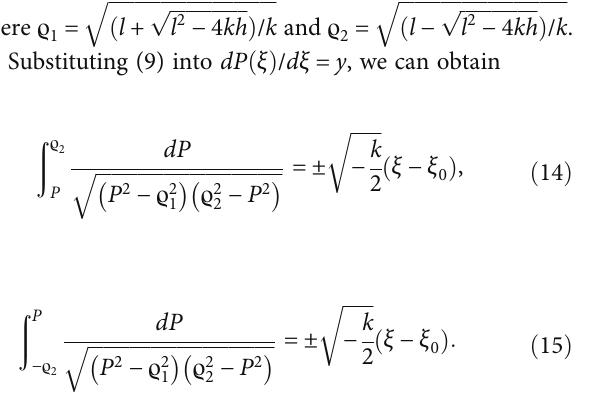
ffiffiffiffiffiffiffiffiffiffiffiffiffiffiffiffiffiffiffiffiffiffiffiffiffiffiffiffiffiffiffiffiffi q ffiffiffiffiffiffiffiffiffiffiffiffiffiffiffi p ð l + l 2 − 4 kh